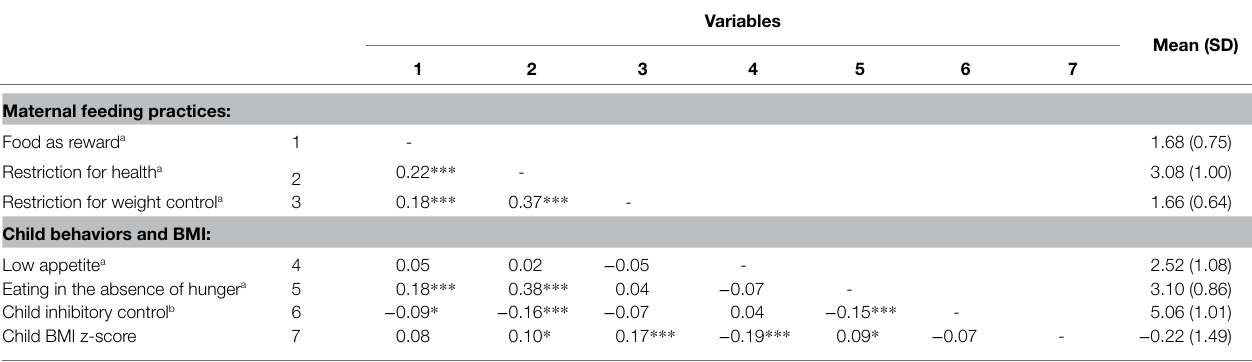
TABLE 3 | Spearman correlations, means, and SDs for study